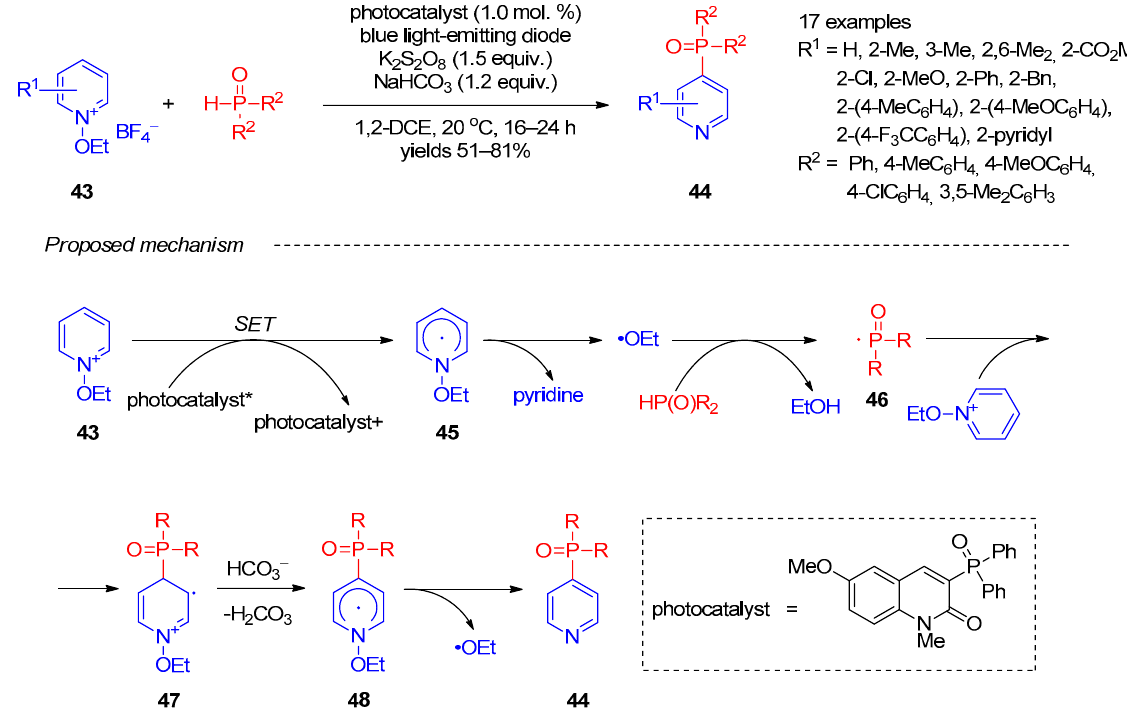
Molecules 2023 , 28 , x FOR PEER